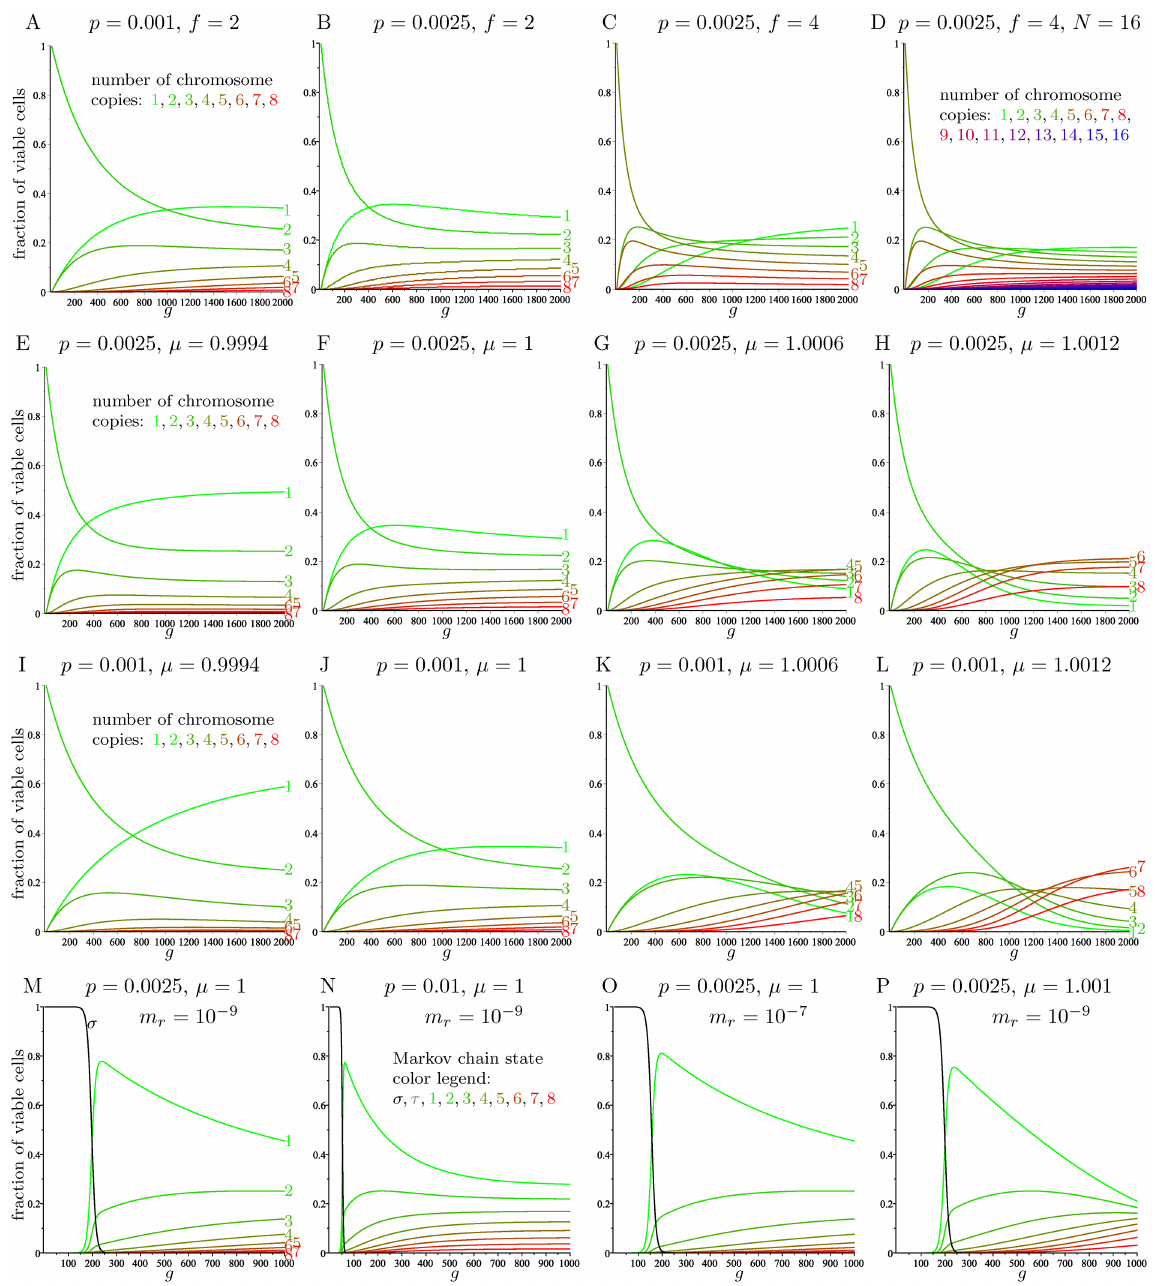
Fig 4. The evolution of the distribution of the number of chromosome copies for the various models. Each curve represents a given number of copies. A—D: Basic model ( M ) with N = 8 (except in D, which uses N = 16), over 2000 generations. E—L: Full model with chromosome scores ( A ) with N = 8 and a founder cell with f = 2 chromosome copies, over 2000 generations. M—P: Modified model incorporating the effects of aneuploidy during early tumor growth ( A ) with N = 8 and a founder cell with 2 active copies of gene X , over 1000 generations. X